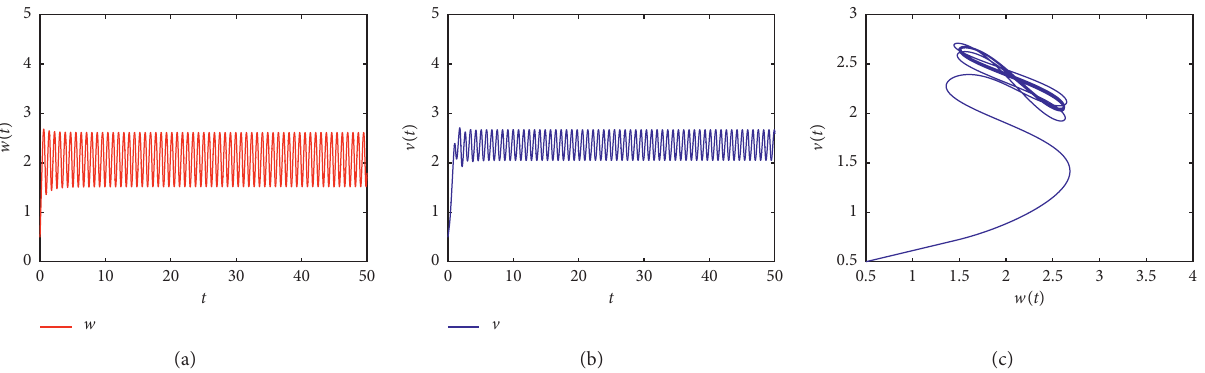
Figure 1: Computer simulation of the paths w ( t ) and v ( t ) for system (16) with the initial value ( w ( 0 ) , v ( 0 )) � ( 0 . 5 , 0 . 5 ) .